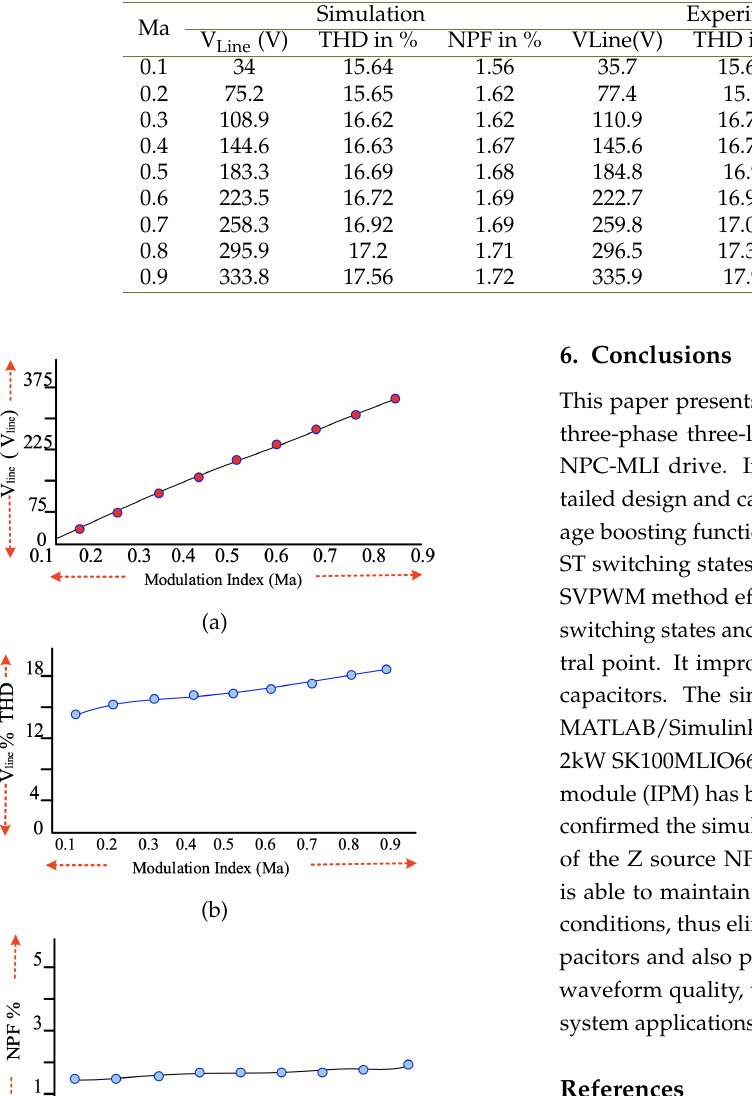
Table 5. Line voltage, Line voltage THD and NPF simulation and experimentation results comparison for different M a